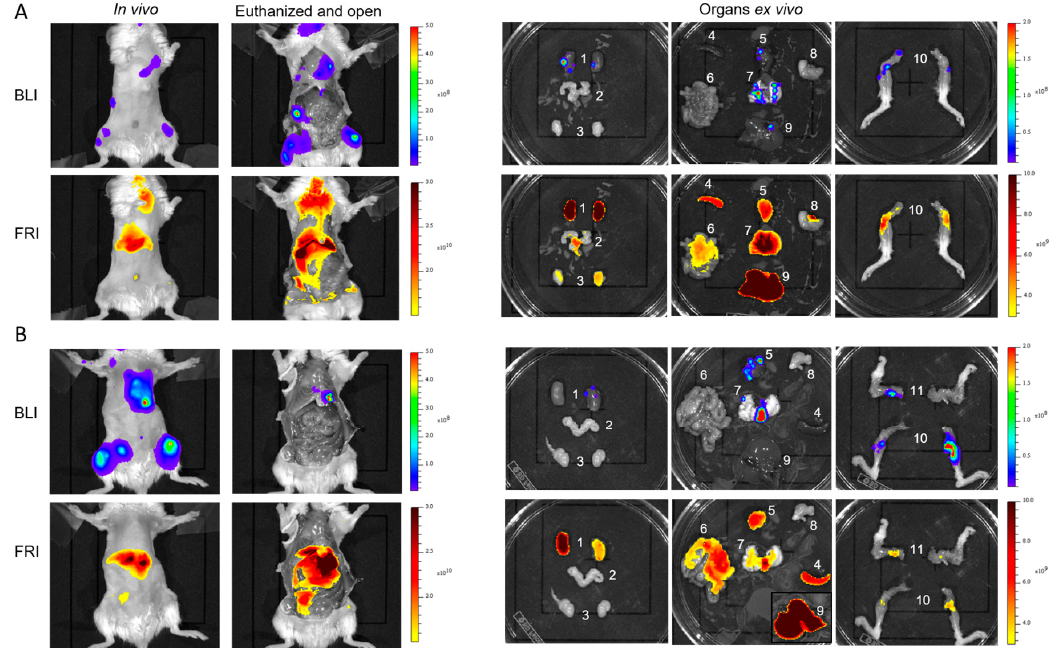
Figure 4. In vivo detection of metastasis. BLI and FRI after LipImage TM 815 injection of 2 representative mice bearing metastatic tumors. Images were taken ( A ) 6 h or ( B ) 24 h after LipImage TM 815 injection first in vivo (column 1), then in euthanized and open mice (column 2). Individual organs were removed and observed by BLI and FRI (columns 3–5). 1: kidneys, 2: prostate, 3: testicles, 4: splenic